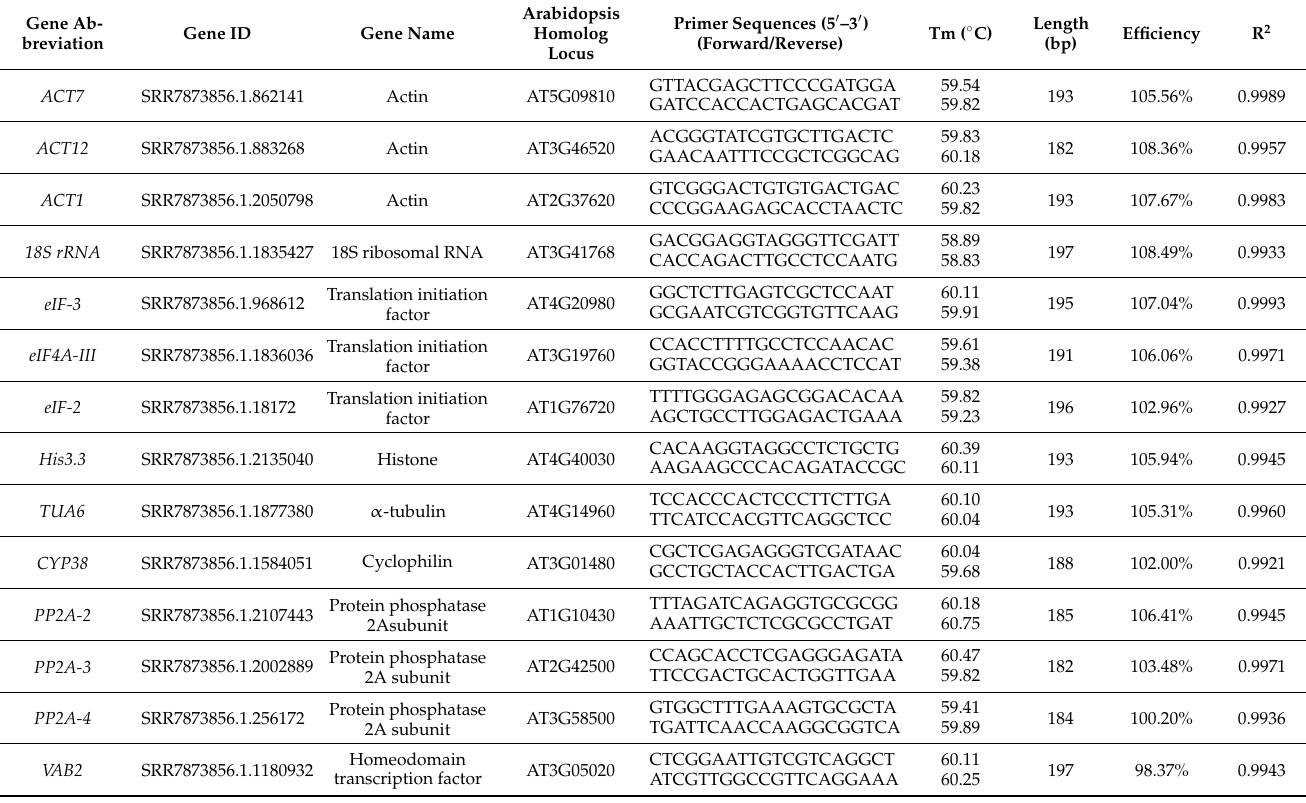
Table 1. Description of the fourteen candidate reference